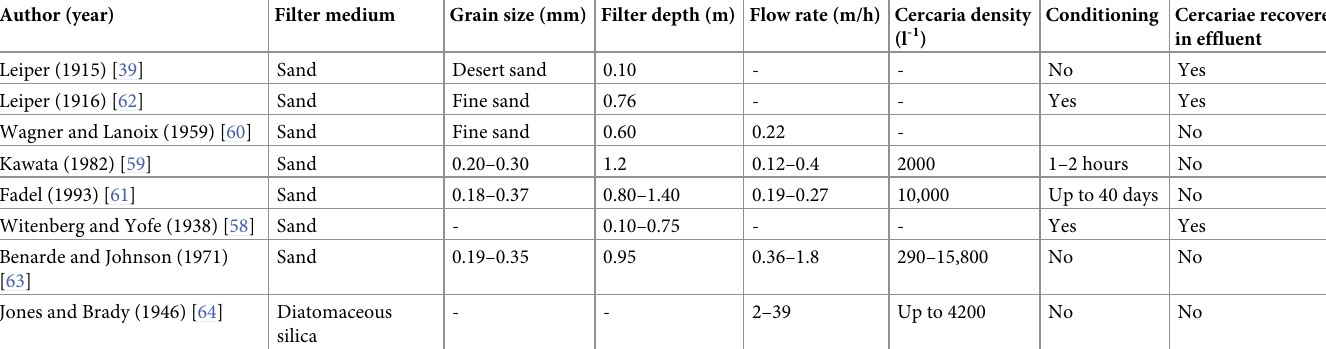
Table 4. Summary of experimental conditions in filtration studies. All studies used S . mansoni cercariae. Author